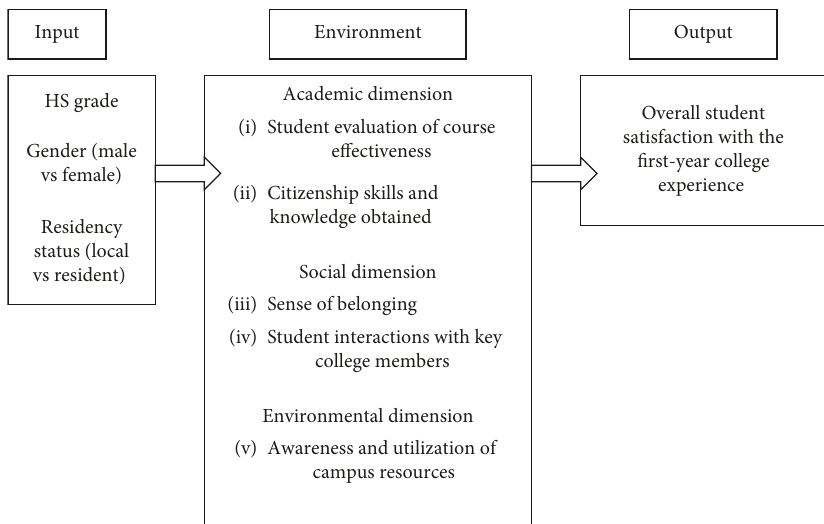
Figure 1: Conceptual model for student satisfaction adapted from Astin’s I-E-O